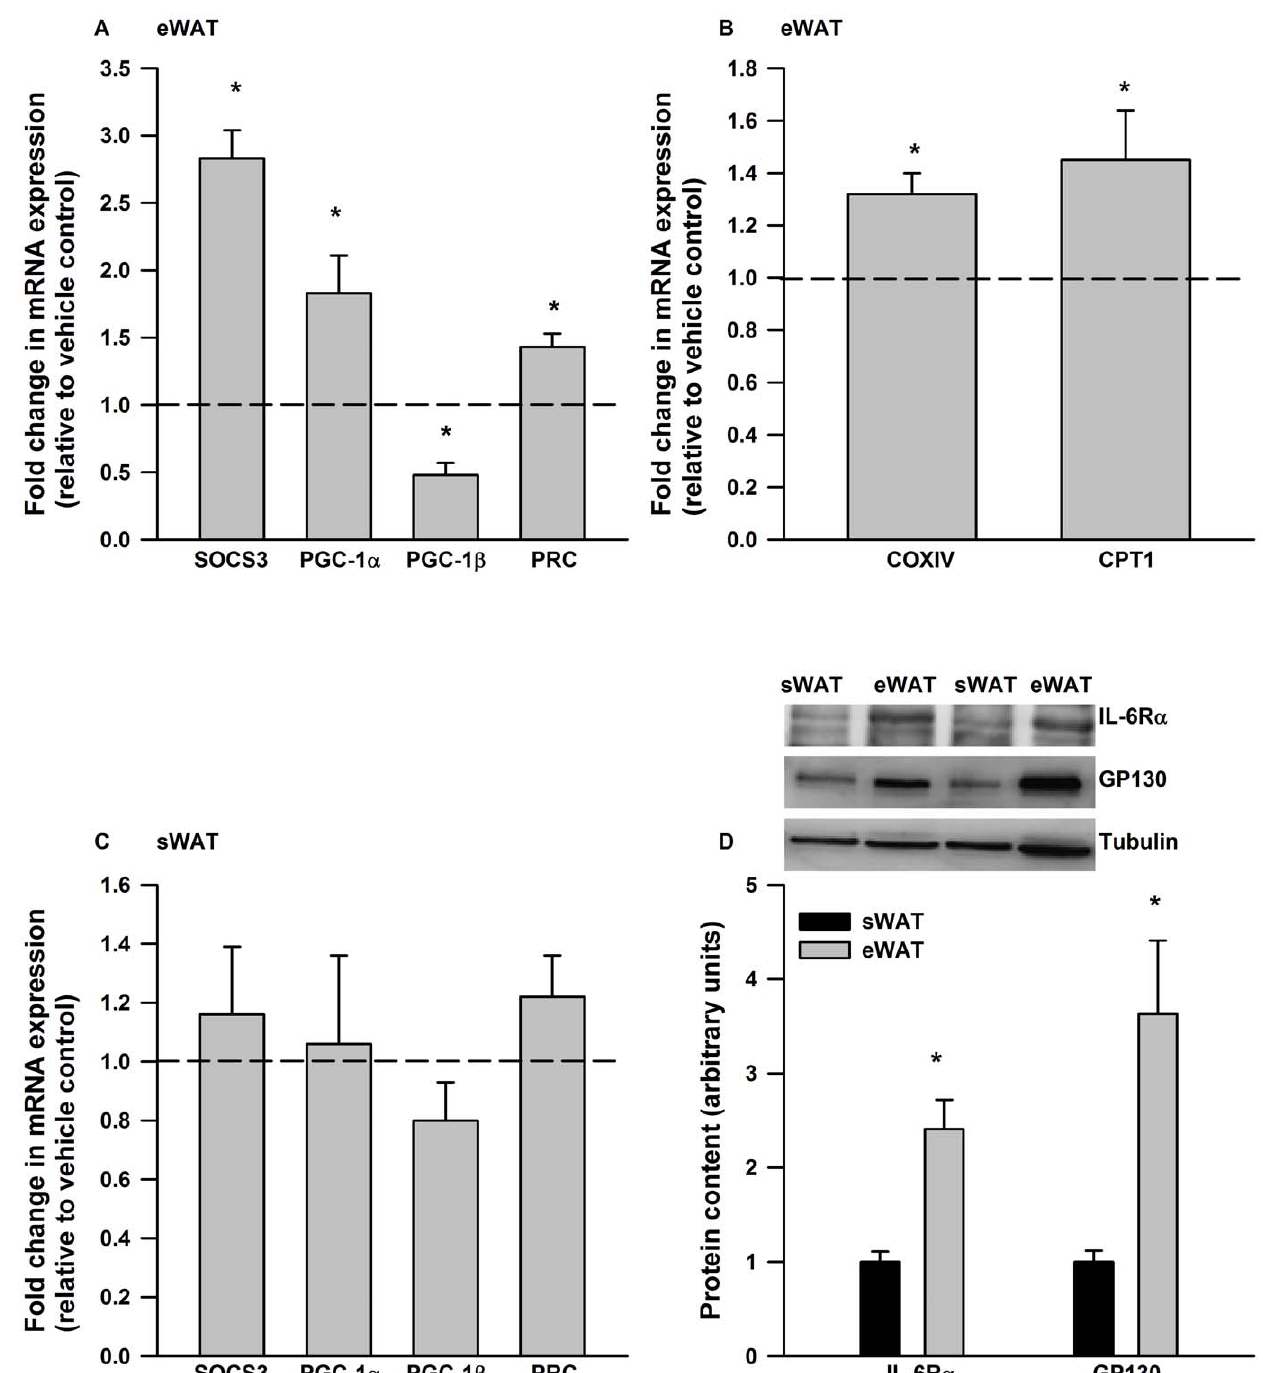
Figure 1. IL-6 exerts depot specific differences in gene expression in mouse adipose tissue. IL-6 treatment (6 hours, 75 ng/ml) increased the expression of A) SOCS3, PGC-1 a and PRC mRNA in cultured epididymal adipose tissue (eWAT). B) A 12 hr IL-6 (75 ng/ml) treatment increased the expression of COXIV and CPT-1 in cultured eWAT. C) Cultured subcutaneous adipose tissue (sWAT) was not responsive to IL-6 treatment (75 ng/ml, 6 hours) and this was associated with D) reductions in the protein content of IL-6 receptor alpha and GP130. Data are presented as means + SE for 7 cultures, each from an individual mouse, per group and is expressed relative to the vehicle treated control culture from the same animal. For the Western blot data in D) data are presented as means + SE for 8–10 mice per group. Representative Western blots are presented above the quantified data. * P , 0.05.